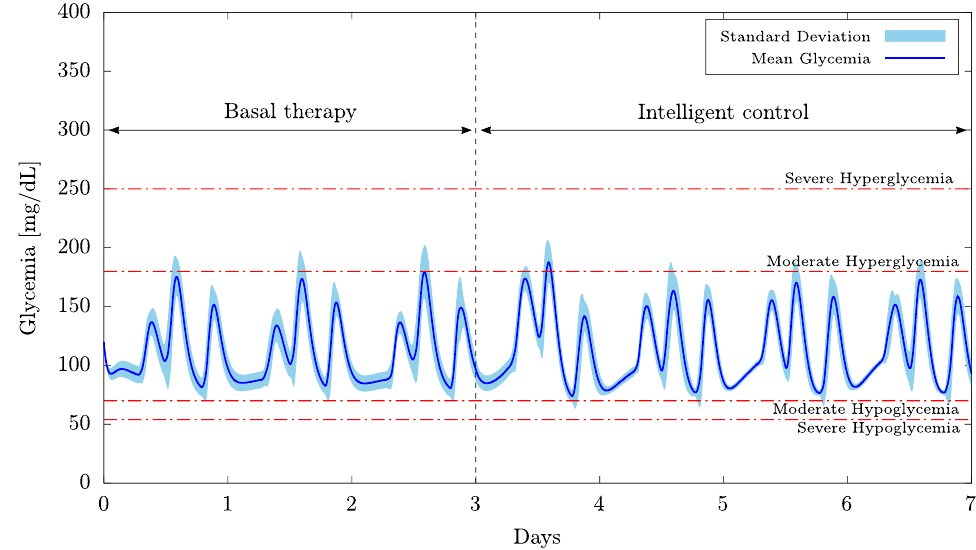
Figure 5. Mean glycemia and standard deviation for 20 patients with prior basal